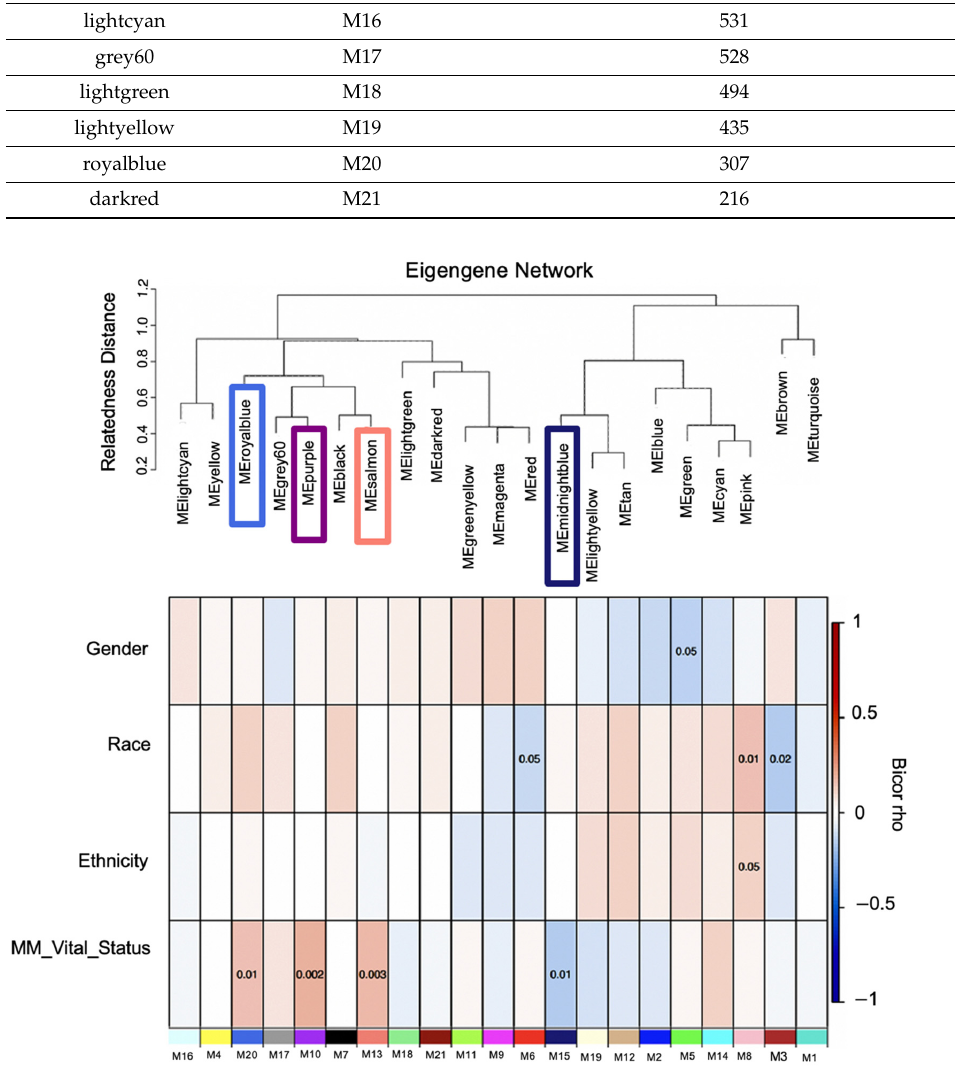
Figure 3. Module-relatedness clustering and module-trait correlations reveal modules associated with multiple myeloma clinical traits. The upper panel shows the dendrogram of consensus